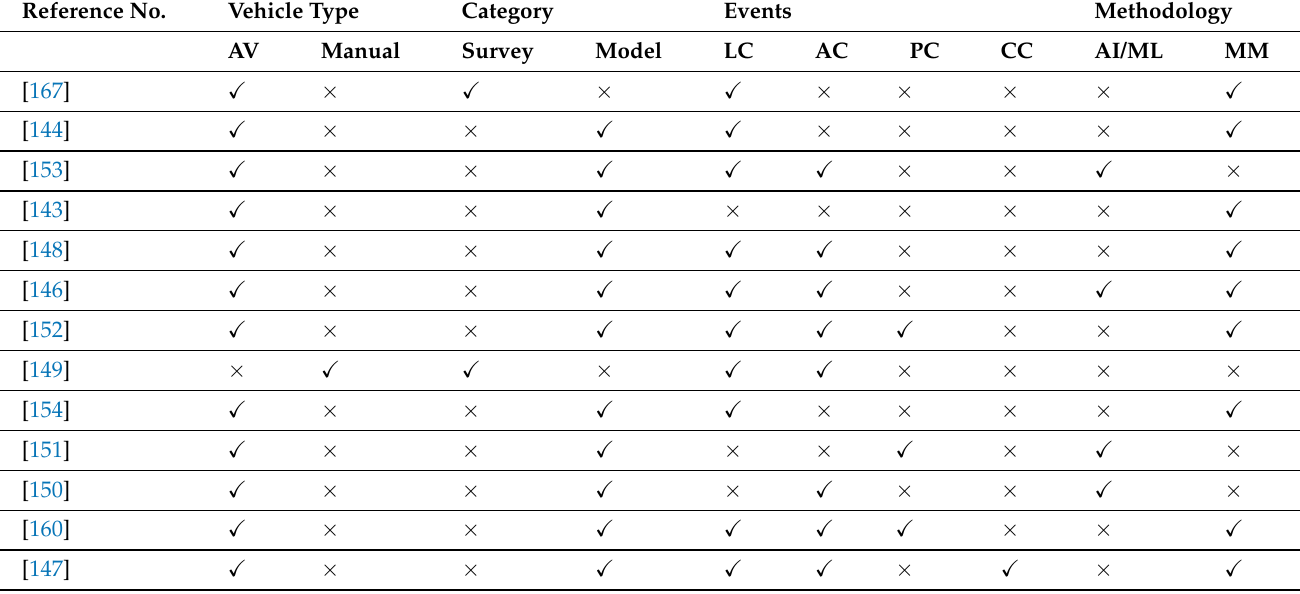
Table 10. Summary of Decision-making in AV (LC—Lane Crossing, AC— Accidents, PC—Pedestrian Crossing, CC—Collision Conditions, and AI/ML—Artificial Intelligence/Machine Learning, MM—Mathematical